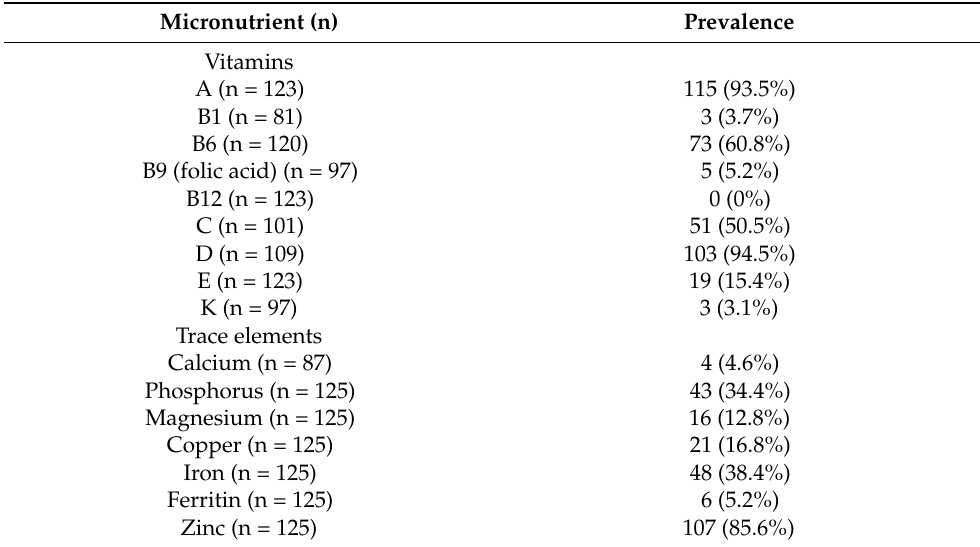
Table 3. Prevalence of micronutrient